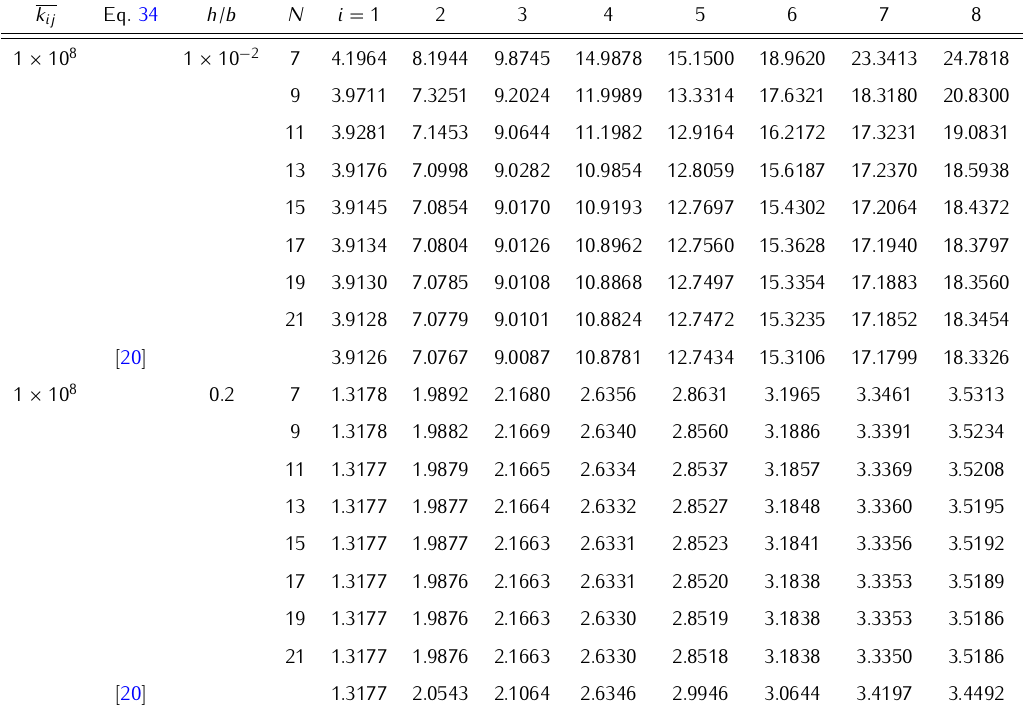
)p ρh/D of cross-ply laminated plates ( 0 ◦ / 90 ◦ /.../ 0 ◦ ) = ( ω i b 2 /π 2 22 / 6 , k / 6 , N x = N y = N ) 44 = 5 55 = 5